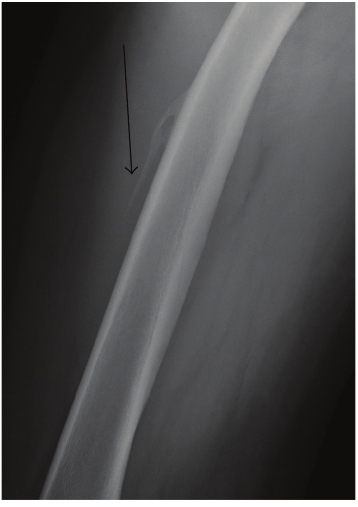
Figure 5: Subperiosteal hematoma (black arrow) of the thigh in a 27-year-old person with